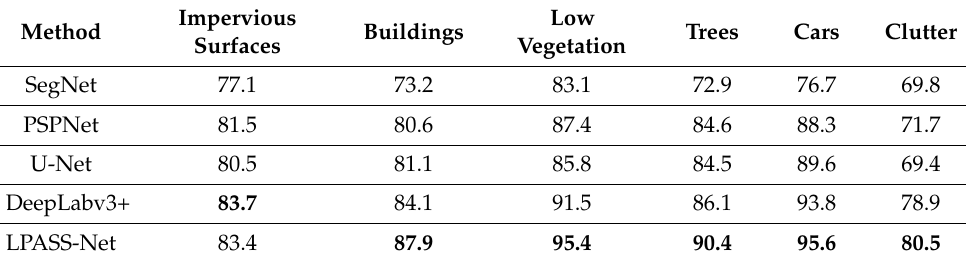
Table 7. The results of IOU on the ISPRS Potsdam dataset of different methods (%), where the bolded numbers indicate the best value for each